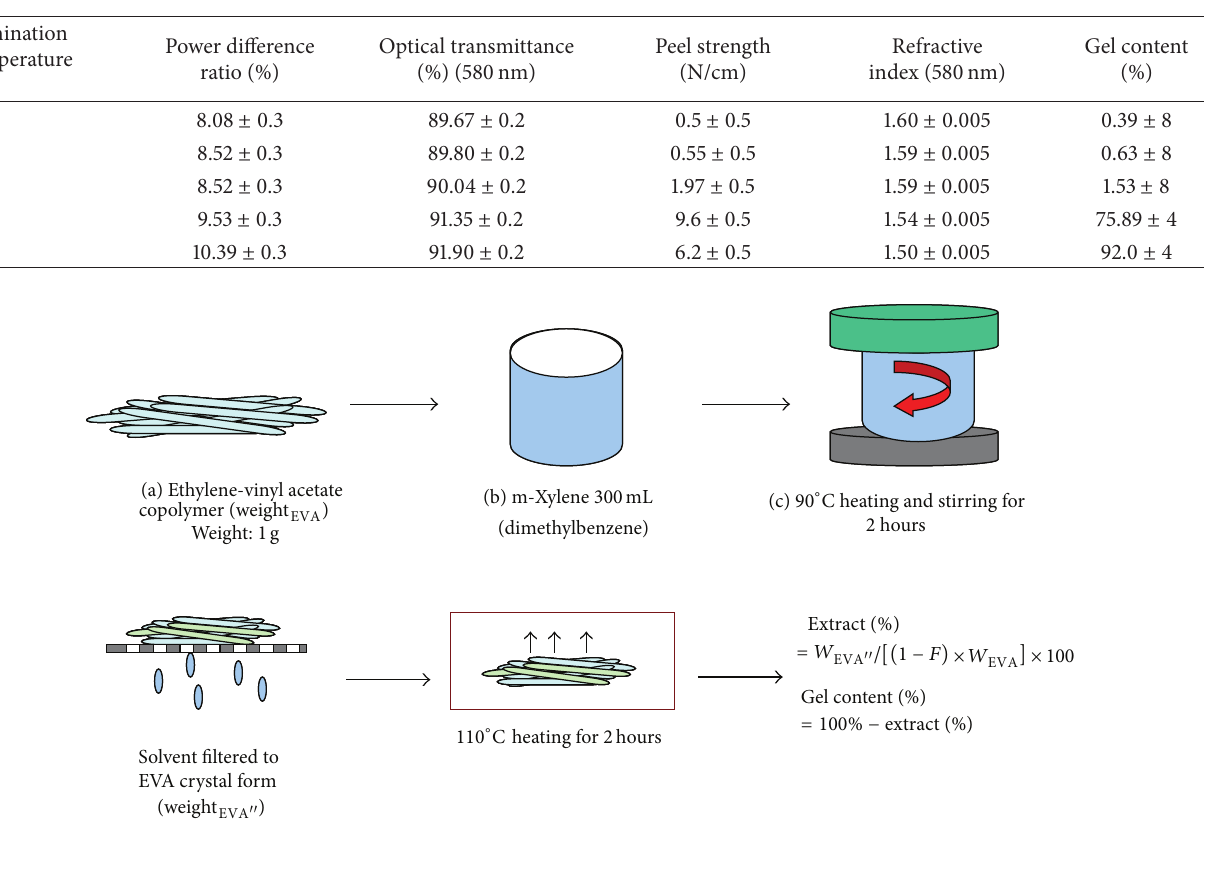
Table 1: The data for the lamination temperature, the power performance, the optical transmittance, the peel strength, the refractive index, and the gel content for the EVA lamination of solar modules.